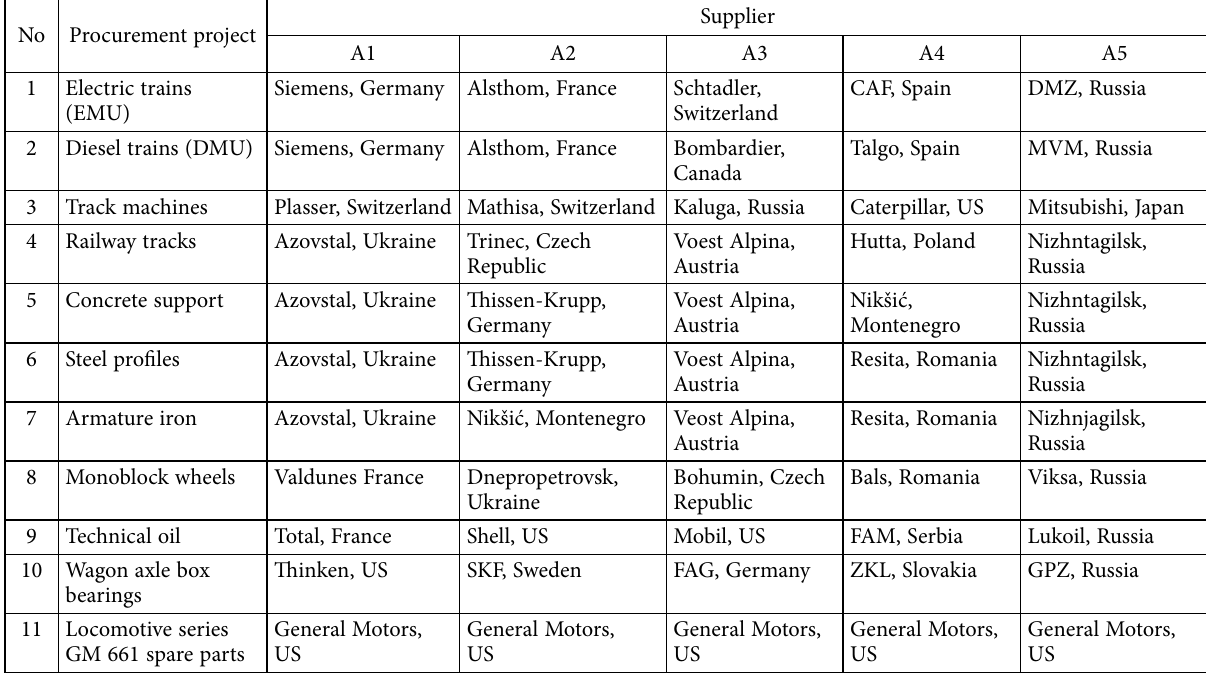
Table 7. Overview of suppliers that applied for project portfolio procurement selection